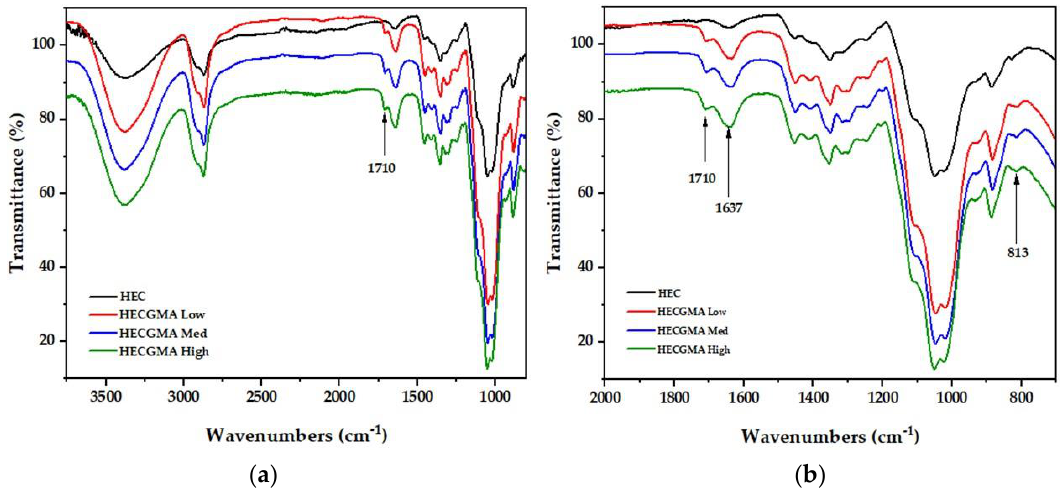
Figure 3. FT-IR spectra of unmodified HEC and HEC modified with GMA at a low, medium, and high molar ratio with wavenumbers ( a ) at the range of 3750 – 750 cm −1 ; and ( b ) at the range of 2000 – 750 cm −1 .